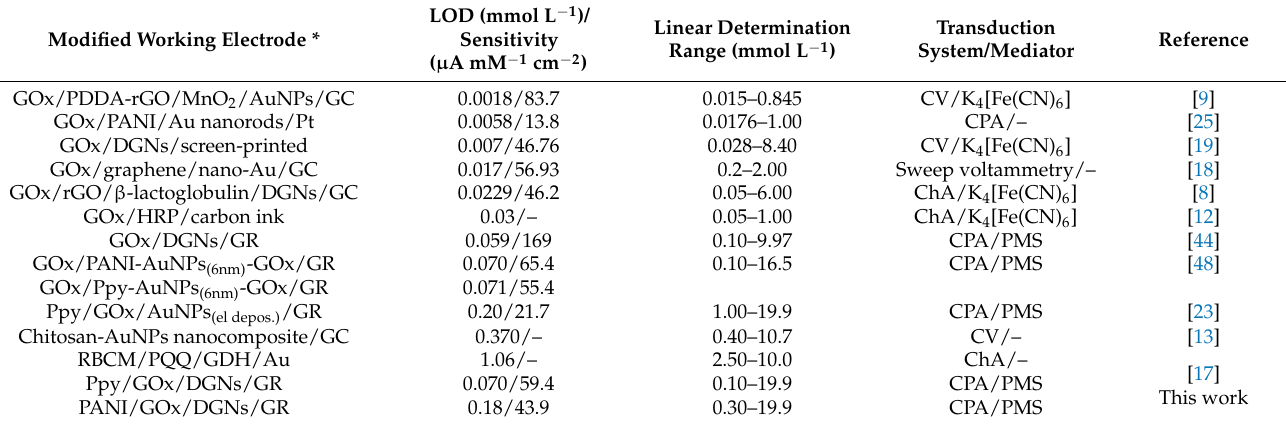
Table 1. Comparison of gold derivative-based glucose biosensors.